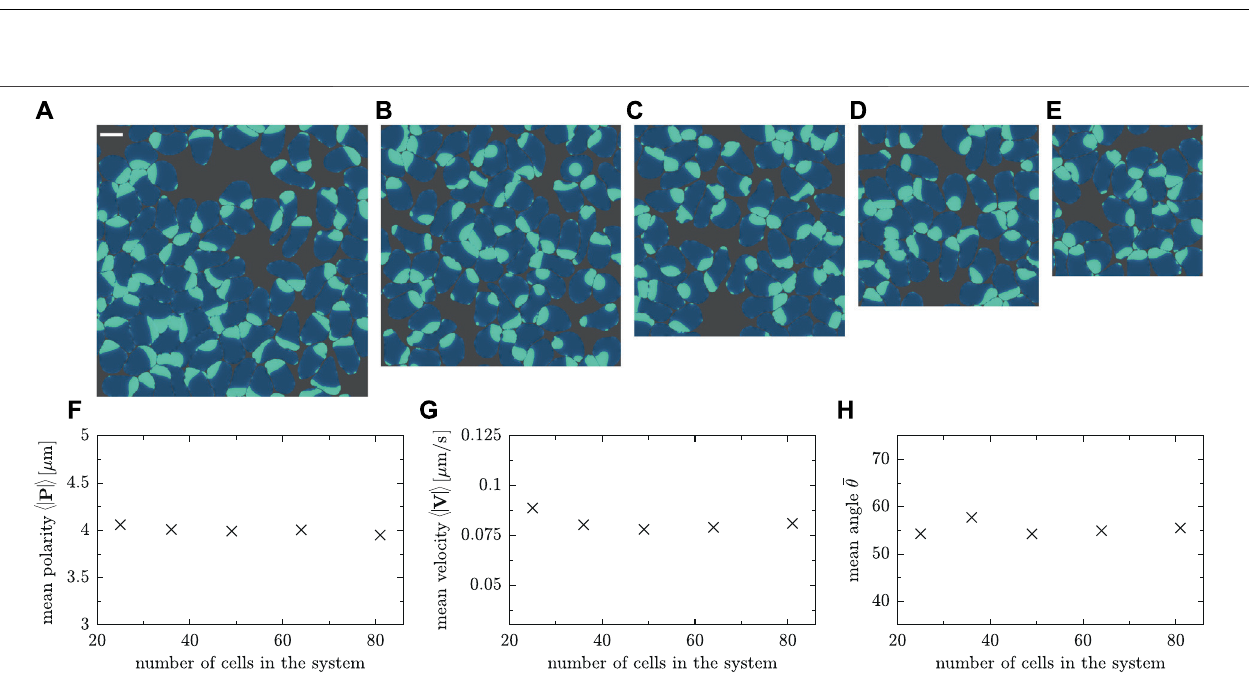
Frontiers in Physics |